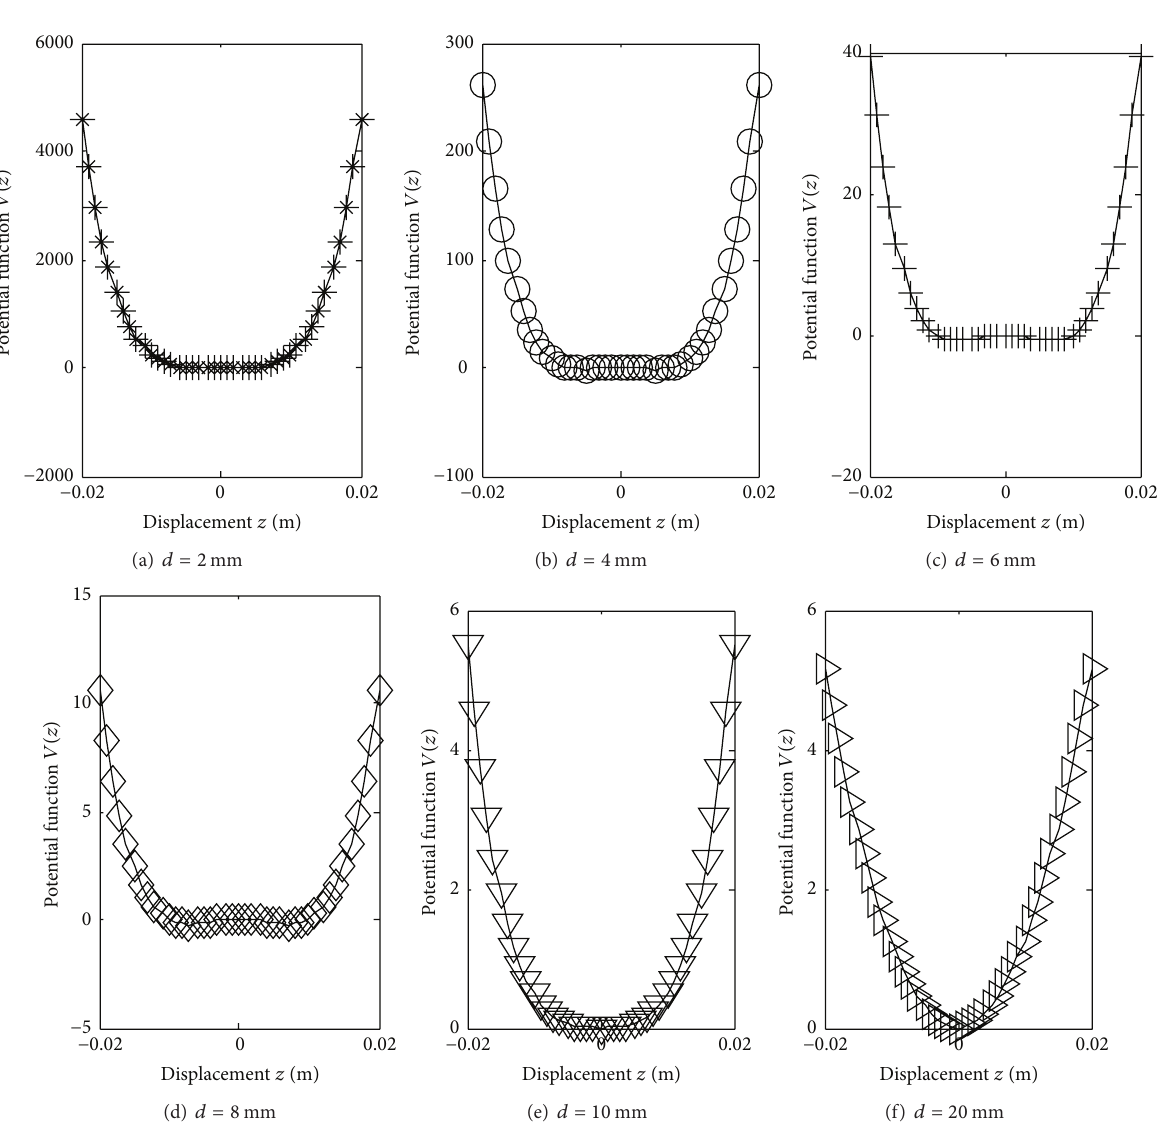
amplitudes are selected as 𝑃 𝑚 = 0.02, 0.04, 0.06, 0.08 .